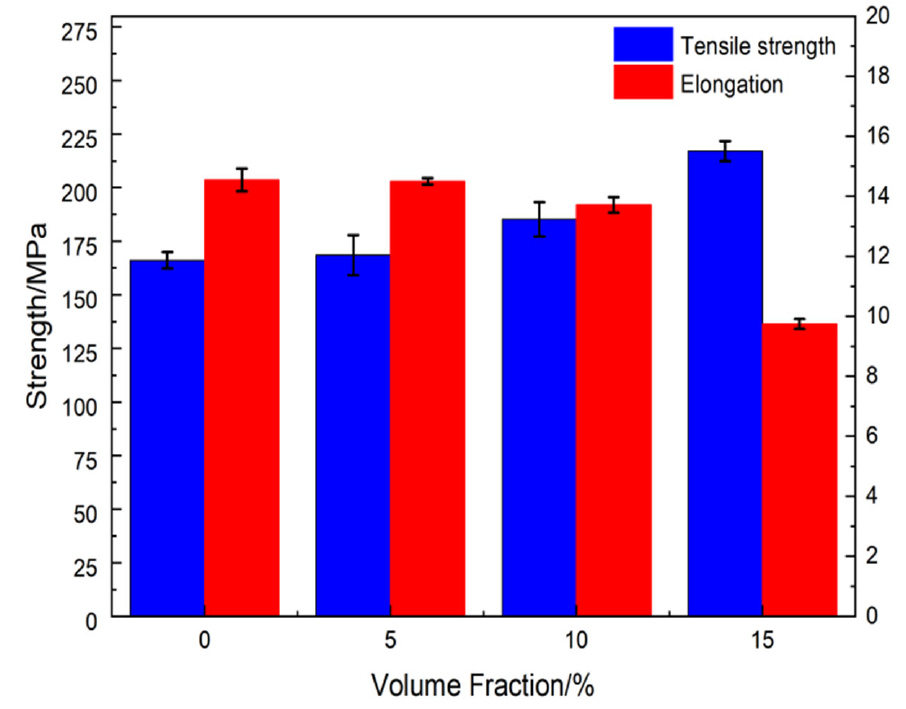
Figure 11. Tensile properties of (AlFeNiCrCoTi0.5)p/6061Al composites with different volume fractions at room temperature (26 °C).